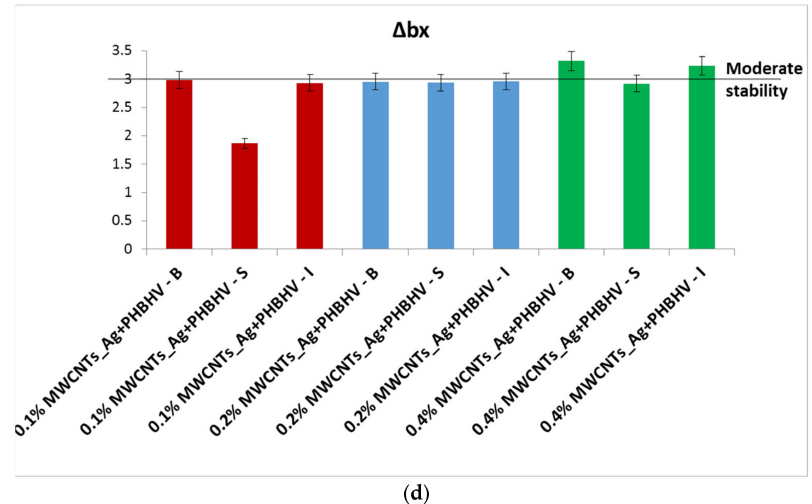
Figure 4. Calculated yellow-blue difference ( ∆ b x ): ( a ) MWCNTs + PHBHV set, ( b ) MWC- NTs_ZnO + PHBHV set, ( c ) MWCNTs_HAp + PHBHV set and ( d ) MWCNTs_Ag + PHBHV set. The results are presented as the mean ± S.D. of three replicates.